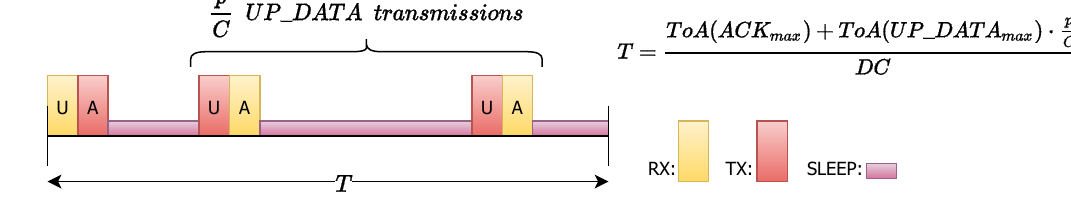
Figure 6. Average worst case situation of a time period in a